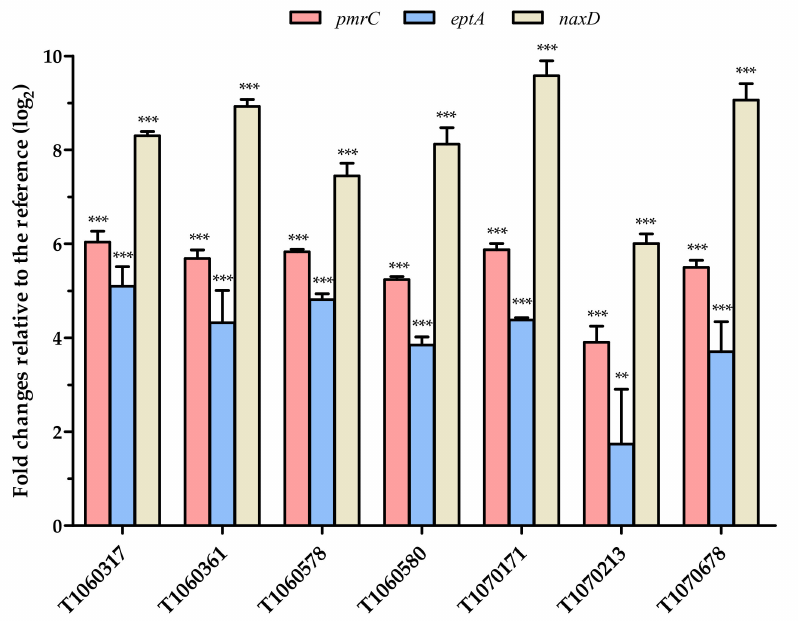
Figure 2. Gene expression levels of LPS modifying enzymes in the CCR-AB isolates. Expression of pmrC , eptA, and naxD was compared to that of the reference strain ATCC 19606. The result was expressed in folds of changes in log 2 scale. rpoB was used as an internal reference for each isolate. The error bars indicate standard errors from three replicate determinations. Statistical analysis was conducted by one-way ANOVA with Dunnett’s test for comparison of individual isolate and the reference. **, 0.001 < p ≤ 0.01; ***, p ≤ 0.001.